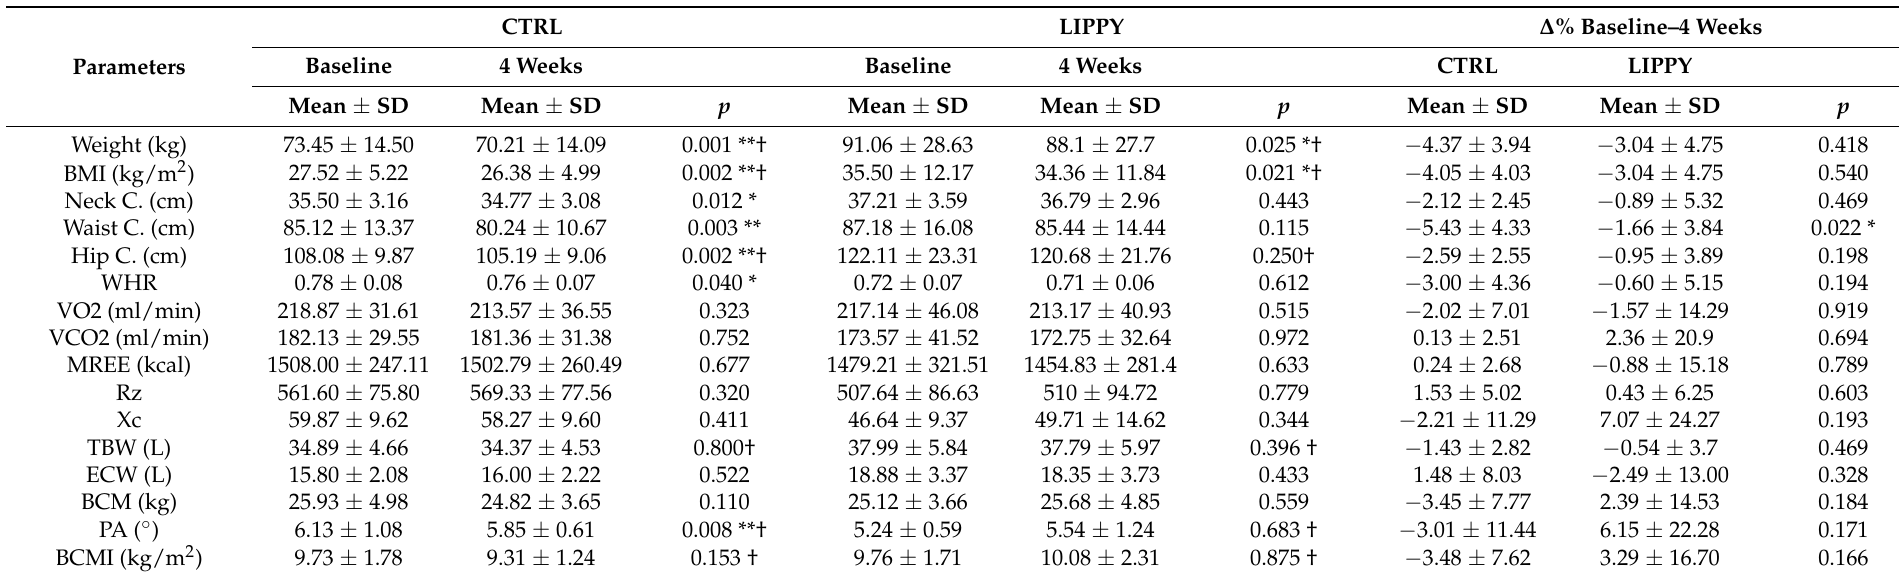
Table 2. Comparison of anthropometric, indirect calorimetry and bioimpedance variables between the baseline and after four